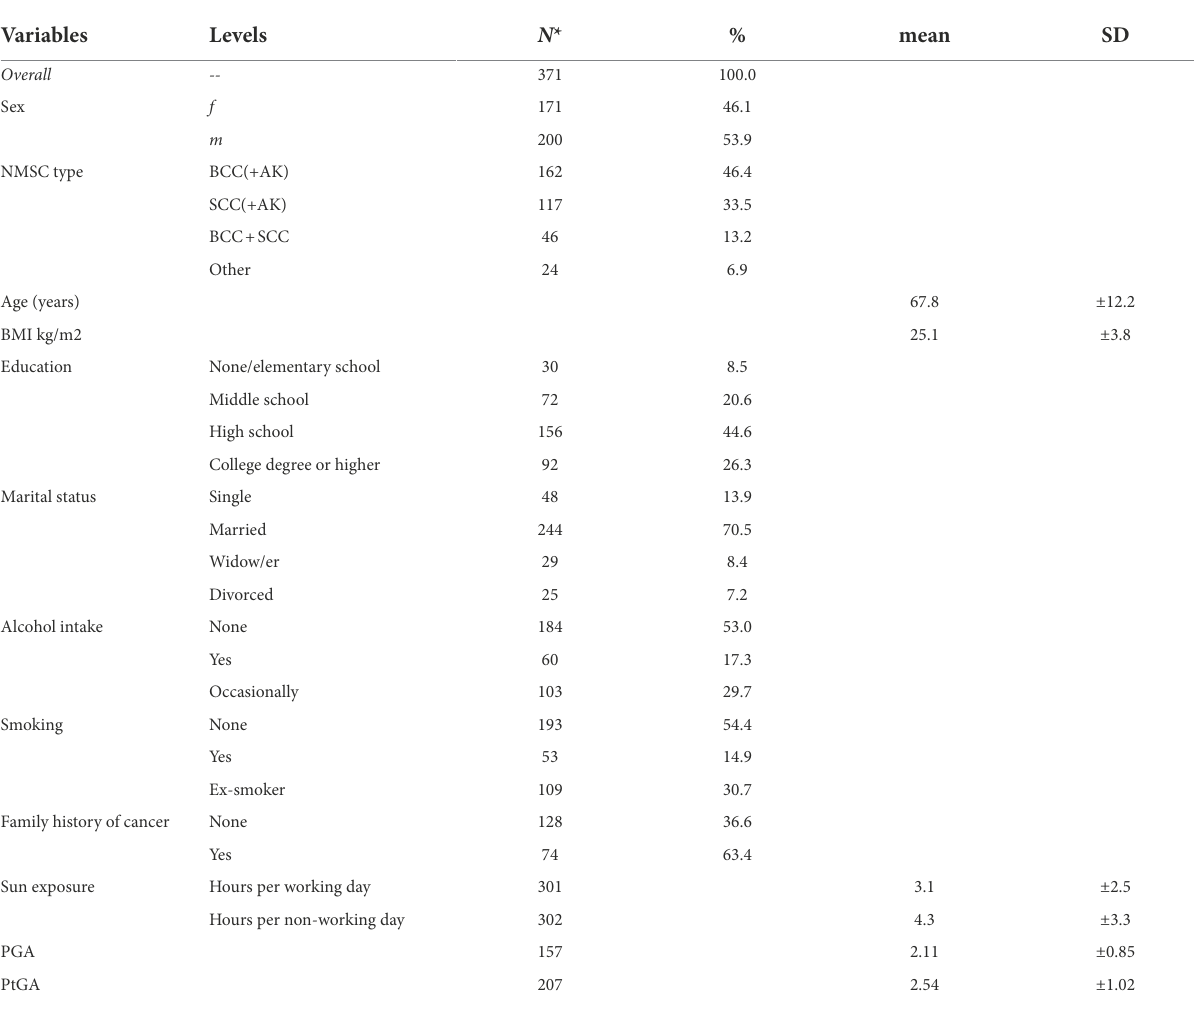
TABLE 2 Sociodemographic and clinical features of the sample.